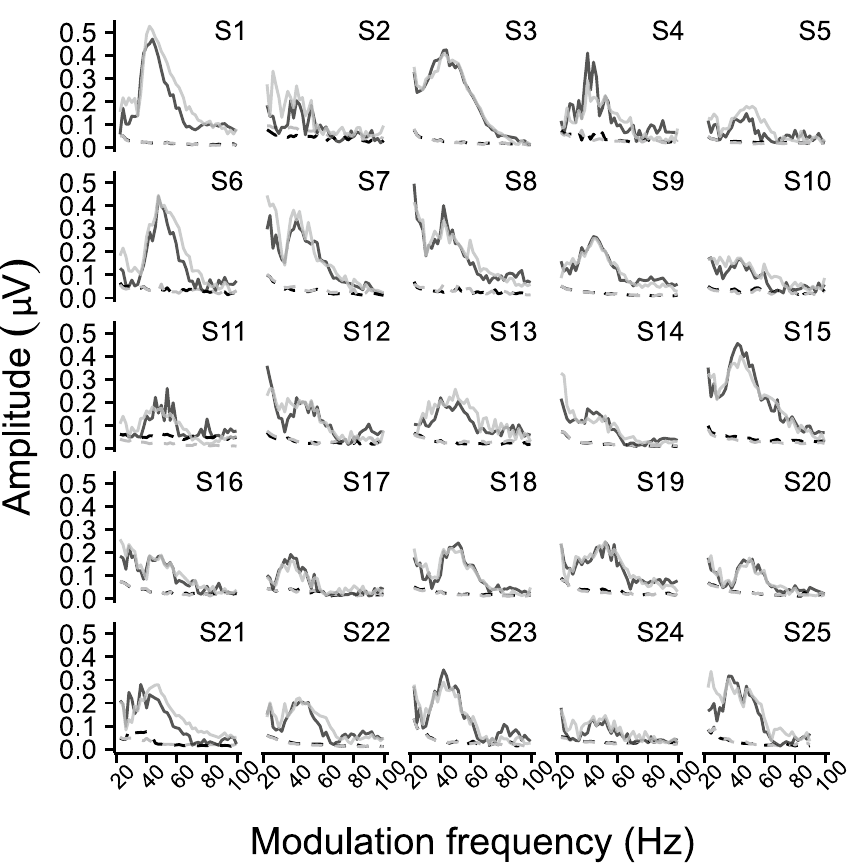
Figure 6. Individual TMTF ASSR within the 20–100 Hz region. The different panels show the biased response amplitude as a function of modulation frequency per subject. Solid lines represent the ASSR amplitude, whereas the dashed lines represent the neural background noise. The left and right hemispheric channel are shown in black and gray, respectively. Comparing the subject-specific TMTF ASSR shows that all subjects had an increased ASSR magnitude, although differences exist across subjects, for ASSRs evoked with modulation frequencies ranging from 30 to 60 Hz and 80–100